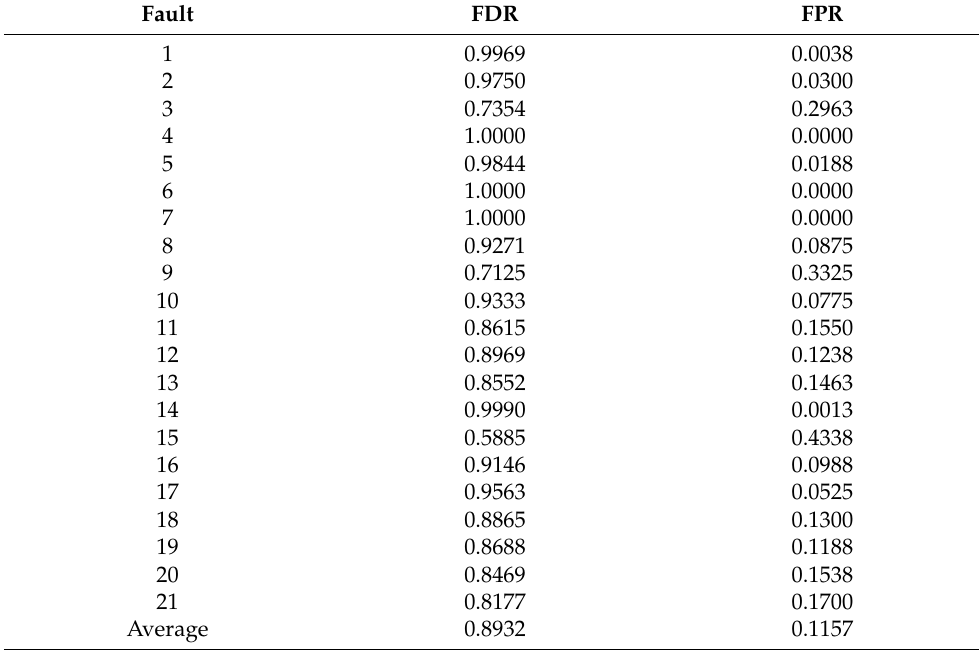
Table 3. Diagnosis results of BCOA-KELM in TE